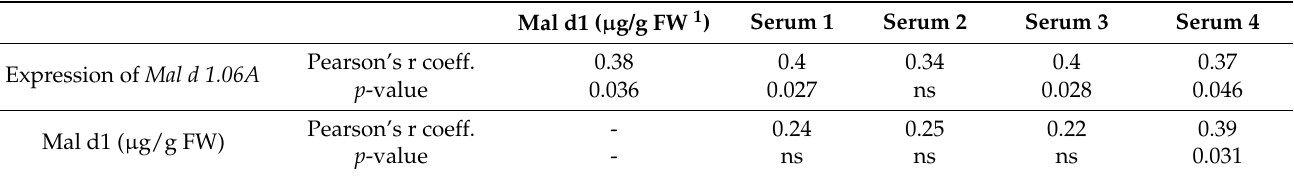
Table 4. Correlation between immunoreactivity of patients’ sera, Mal d 1.06A expression, and Mal d 1 content. Mal d1 ( µ g/g FW 1 ) Serum 1 Serum 2 Serum 3 Serum 4 Pearson’s r coeff. 0.38 Expression of Mal d 1.06A p -value Pearson’s r Mal d1 ( µ g/g FW)